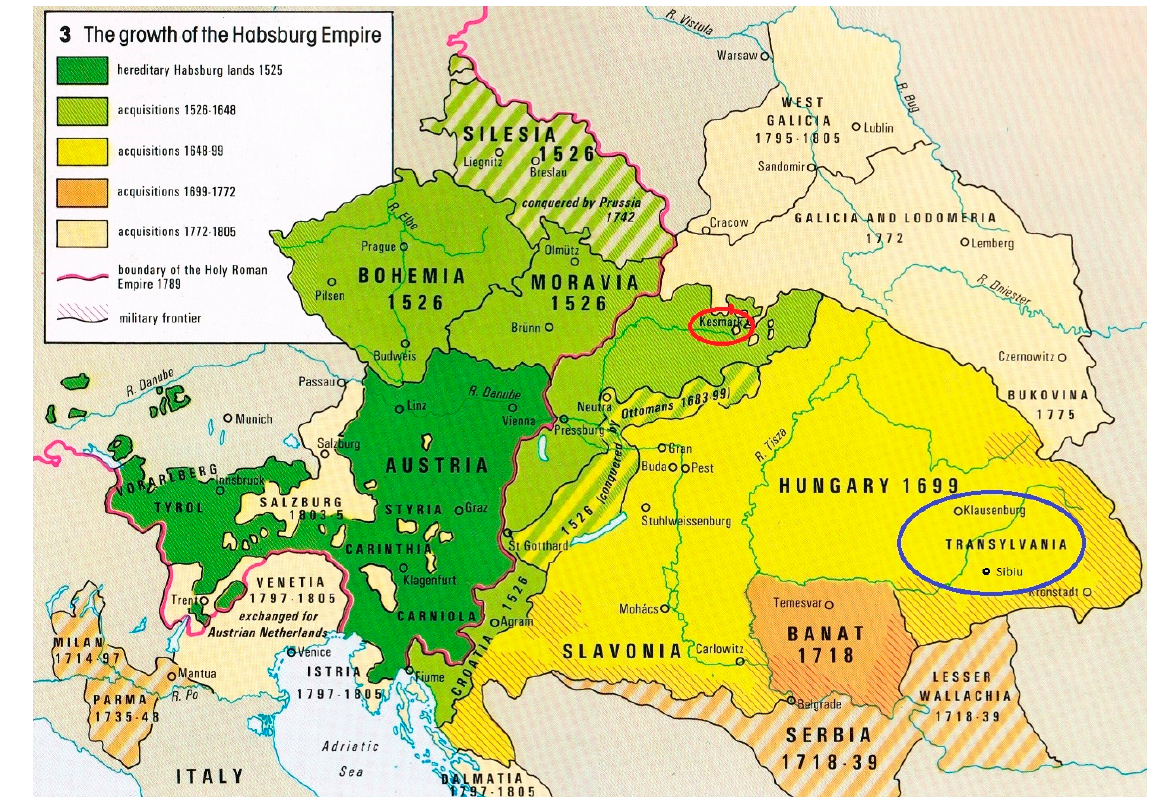
Figure 3 . The Growth of the Habsburg Empire (the red circle denotes where Augustini worked and lived; the blue circle indicates a part of Transylvania which he describes). Source: Kolbe, 2021 [25].